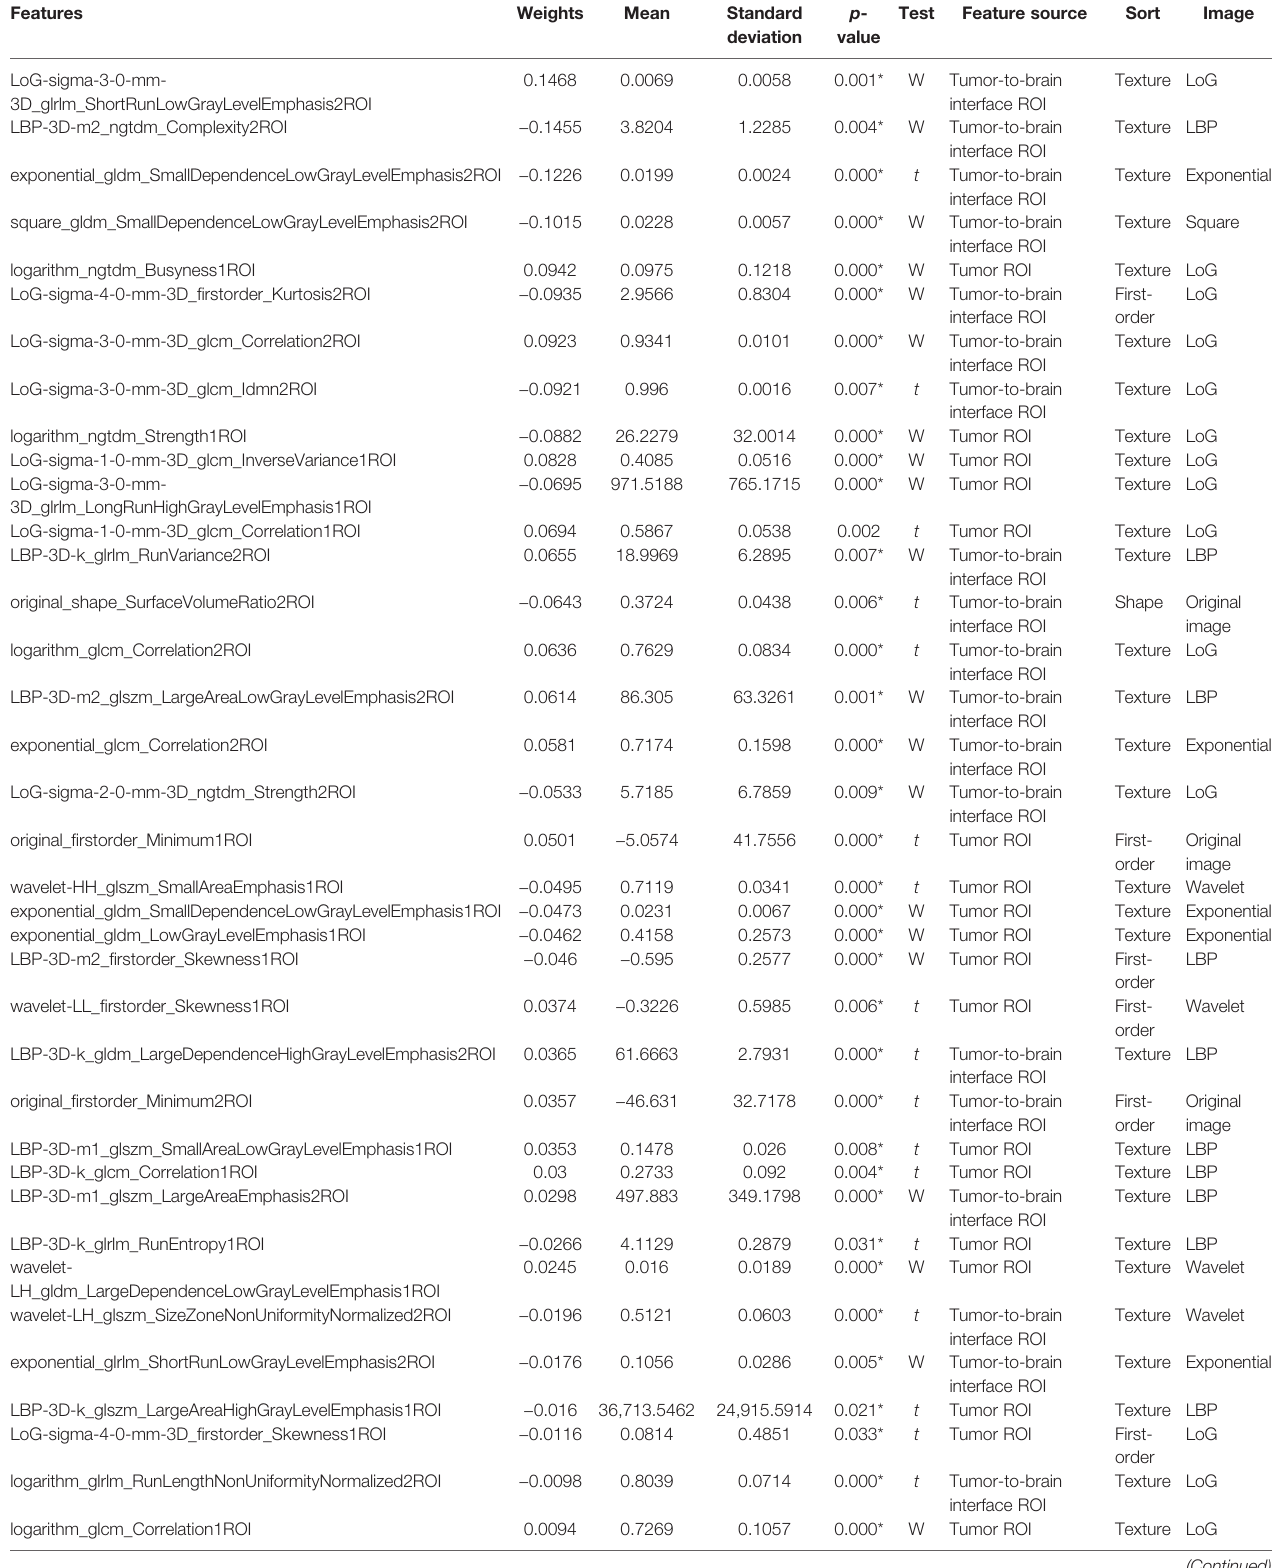
TABLE 3 | Statistics of all the selected radiomics features.